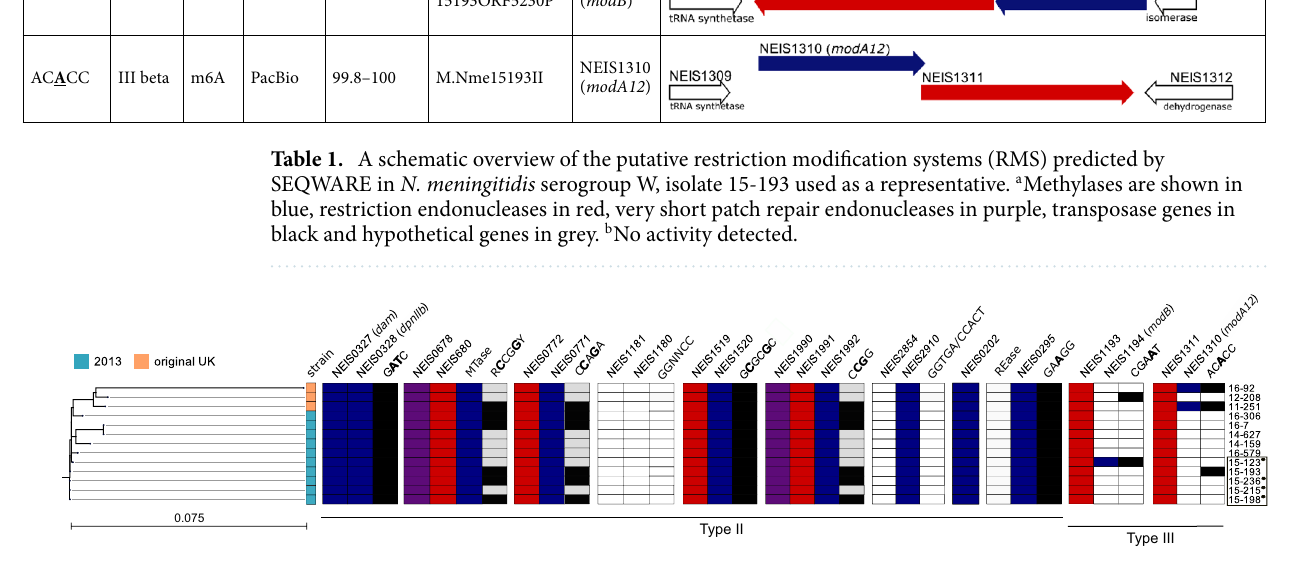
Figure 1. Restriction-modification systems in the 13 isolates belonging to the N. meningitidis 2013 strain marked in blue and original UK strain in orange. Active genes (without inactivating mutations) are coloured: blue = active methylase, red = active restriction endonuclease (REase), purple = active very-short repair endonuclease. Motifs detected by single-molecule real-time sequencing or MspJI cleavage are black, grey = MspJI data not available. The tree on the left shows the phylogeny of the isolates based on single- nucleotide polymorphisms. Isolates from the Jamboree outbreak are marked on the right hand side in a black box, carriage isolates are marked with a star-shaped